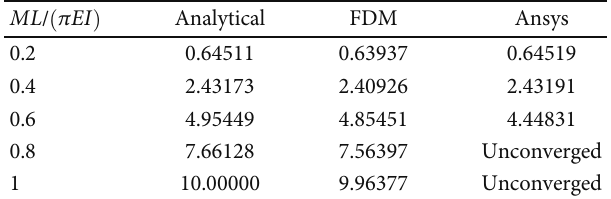
Table 1: Comparison of tip axial displacement using FDM and Ansys (m).